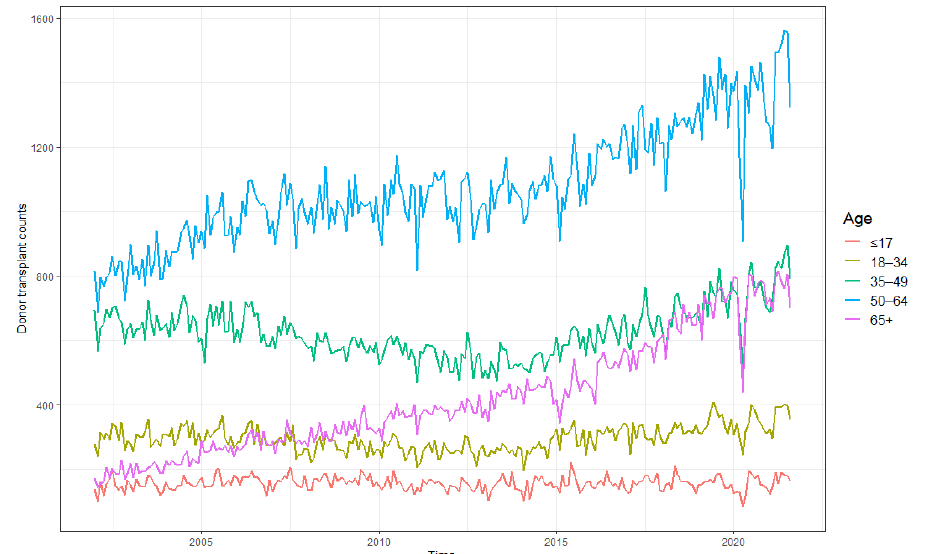
Figure 9. All donor transplant counts in the US across different age groups, based on OPTN data as of November 2021.